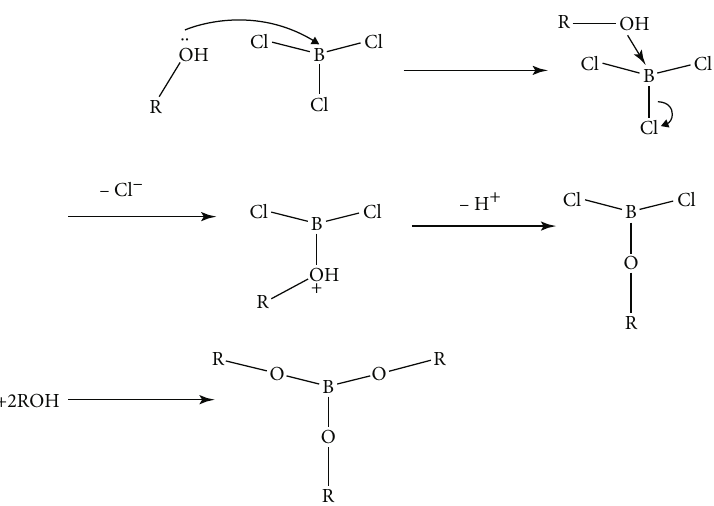
Figure 16: The mechanism of chemisorption of boron chloride on